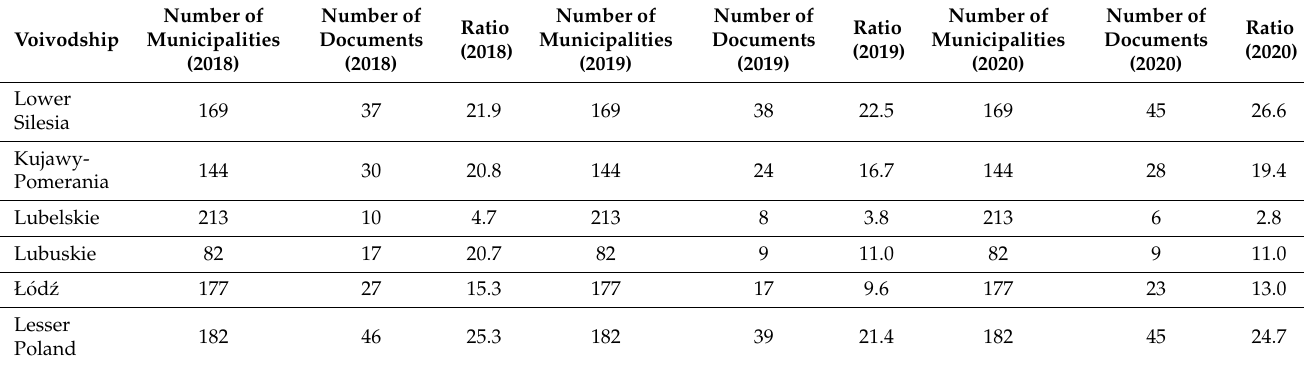
Table 3. Municipalities’ energy planning in a voivodship perspective for